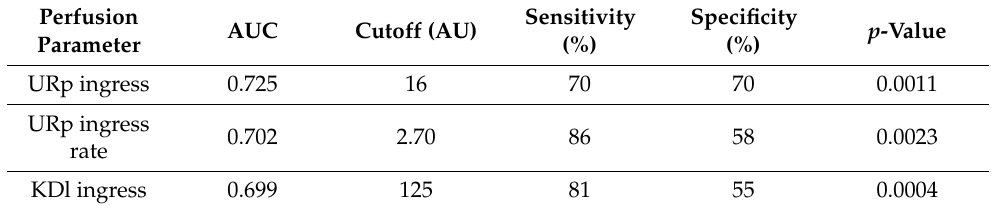
Table 5. Cutoff values of the ICG perfusion parameters ingress and ingress rate given in AU at different localizations for post-transplant ureterovesical anastomosis